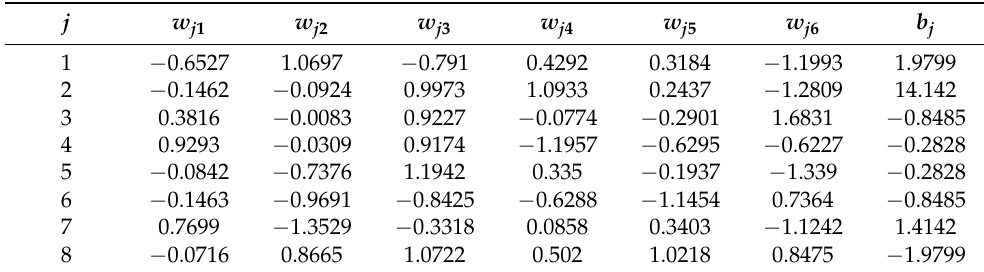
Table 7. Weights and bias of the optimized ANN architecture for the first hidden layer to the second hidden layer.